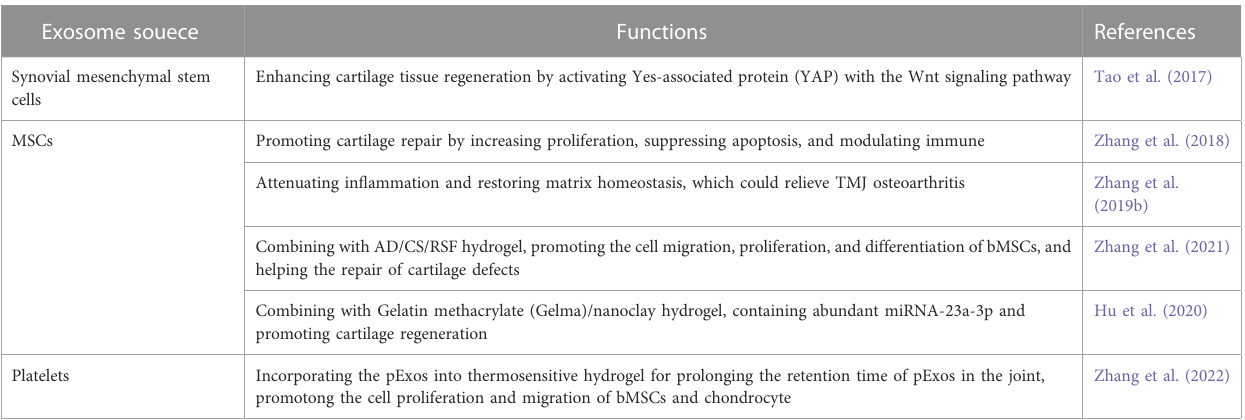
TABLE 2 Application of exosomes for cartilage tissue